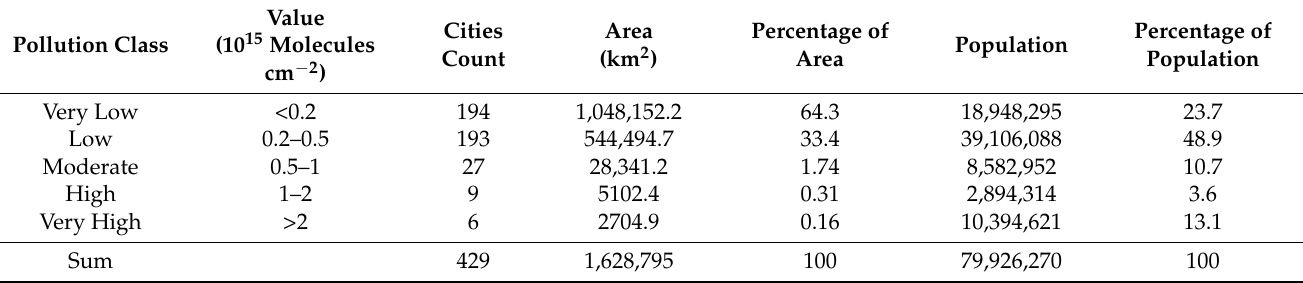
Table 4. Specifications of population statistics using NO 2 (10 15 molecules cm − 2 ) classes.